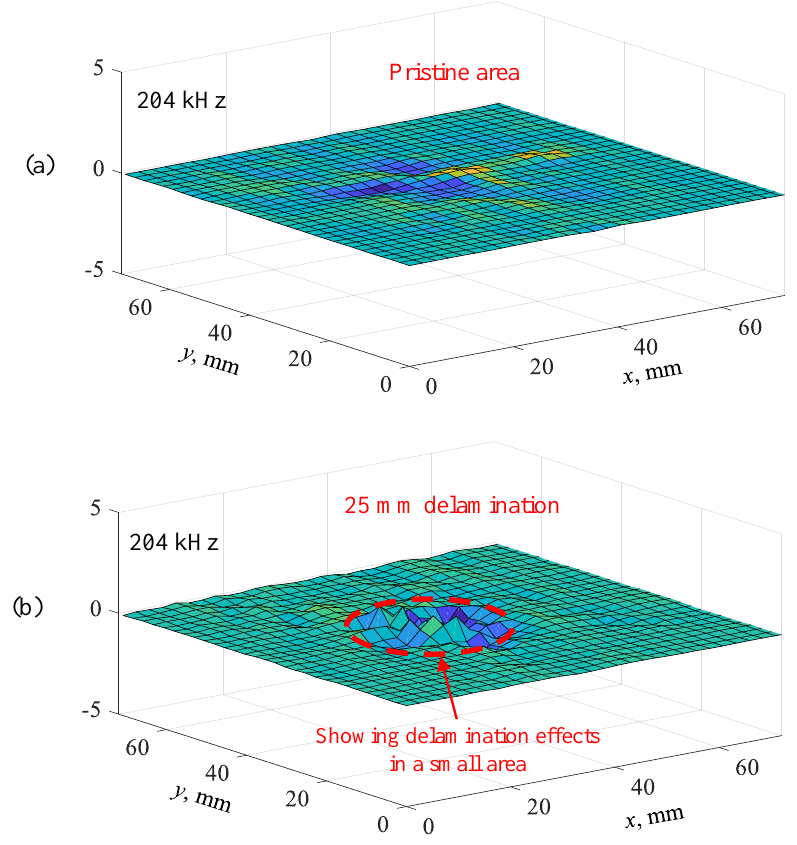
Figure 18. Comparison of measured operational vibration shapes on the cross-ply CFRP composite plate: ( a ) pristine area at 204 kHz; ( b ) 25 mm delamination at resonance frequency of 204 kHz.